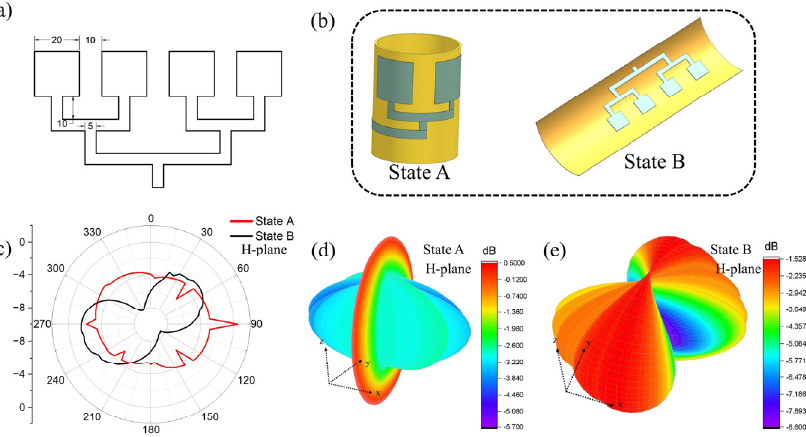
Figure 6. ( a ) Digital image of the geometry and size of the antenna array’s radiation layer. ( b ) Schematic diagram of the pattern of the bi-stable antenna array. ( c ) Radiation patterns of the H-plane of the bi-stable antenna array at states A and B. ( d ) 3D radiation pattern of state A. ( e ) 3D radiation pattern of state B.